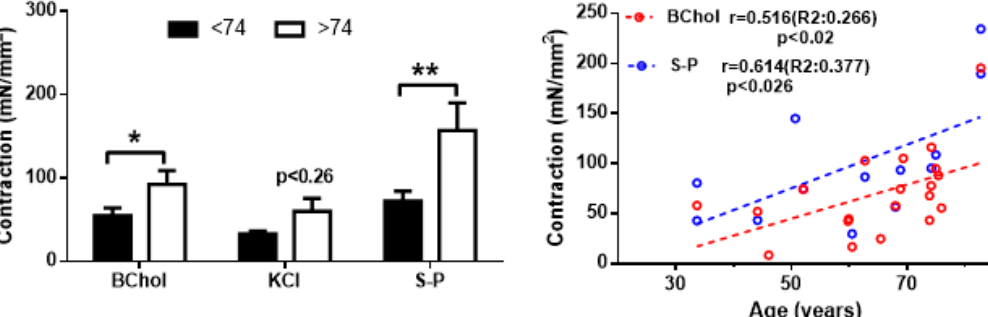
Figure 6. Age-related increase in the myogenic contraction of human colon muscle. Strips of circular colonic smooth muscle were challenged with 100 µM bethanechol (BChol), 60 mM KCl or 10 µM substance P (S-P). Left: Bars represent average ± SEM isometric contraction amplitude from 4–13 experiments from separate individuals. Right: correlation between age and contractility for bethanechol and substance P. * p < 0.05, ** p < 0.02.